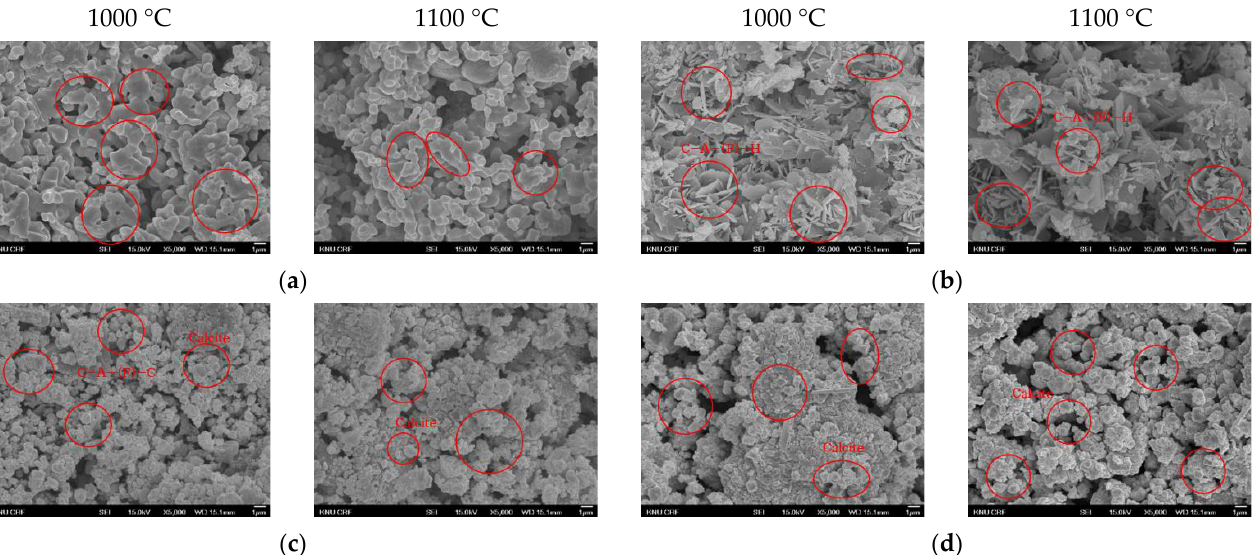
Figure 7. Scanning electron micrographs (×5000) of carbonation sintered at 1000 °C and 1100 °C. ( a ) OH; ( b ) 1H; ( c ) 3H; ( d ) 6H.